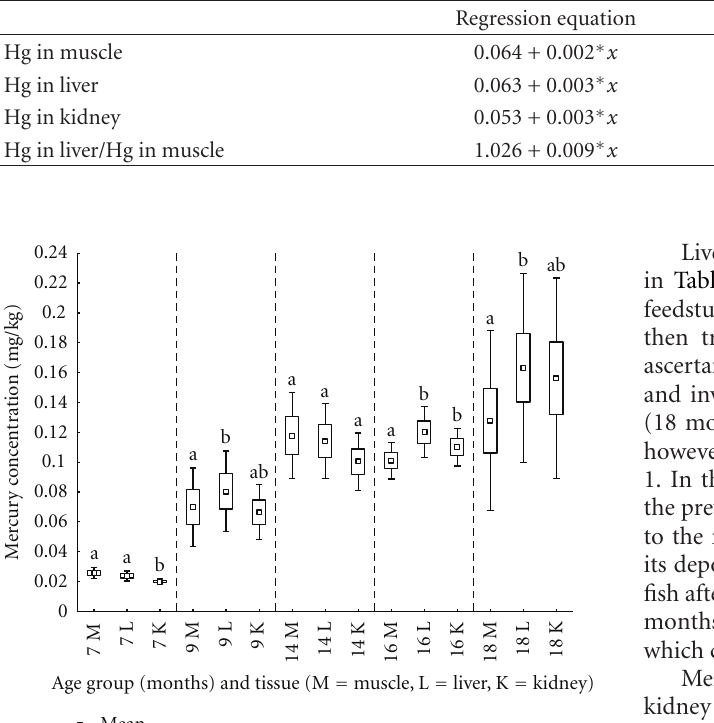
Figure 5: Mercury concentrations in muscle, liver, and kidney in individual age